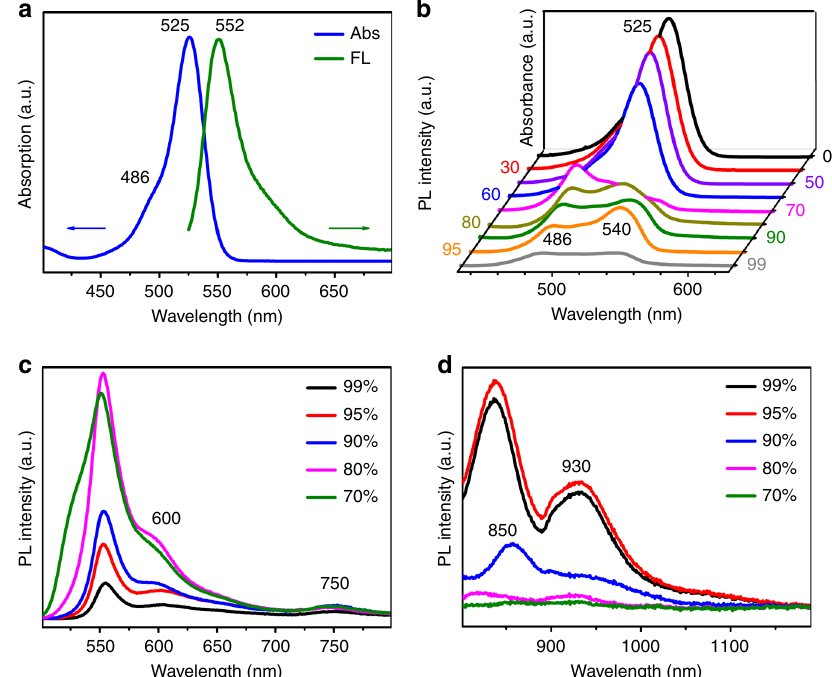
Fig. 2 Photophysical properties of BDP1 in THF and THF/water mixtures. a Absorption and emission spectra of BDP1 in THF at 1 × 10 − 5 mol L − 1 . b Absorption and c , d emission spectra of BDP1 in THF/water mixtures with varied volumetric fractions of water ( f w